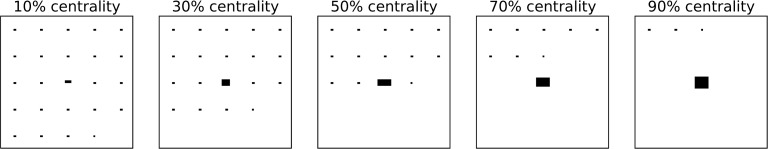
Patterns of signal used in simulation Experiment B.These are the patterns of signal that were added to 100 x 100 noisey fields to generate simulated neural data for Simulation Experiment B. Percent centrality is defined as the percentage of features in the largest cluster.